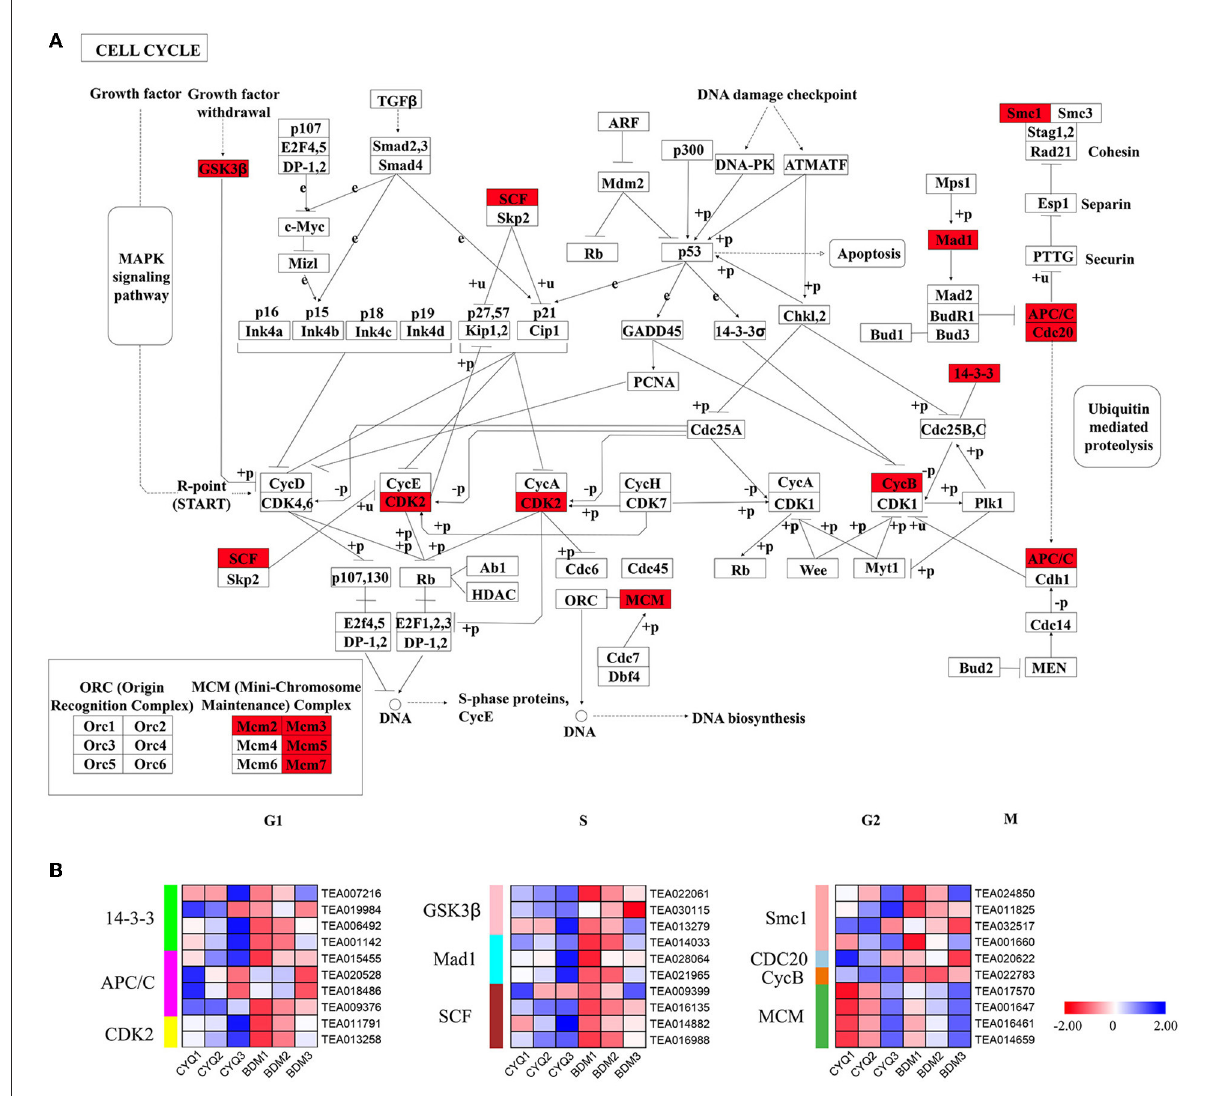
FIGURE9 The cell cycle pathway and related gene expressions. (A) Cell cycle map of KEGG. Red color indicated DEGs in the cell cycle pathway. (B) Expression analysis for DEG associated with the cell cycle. The expression levels of DEGs were normalized by log 2 (FPKM).